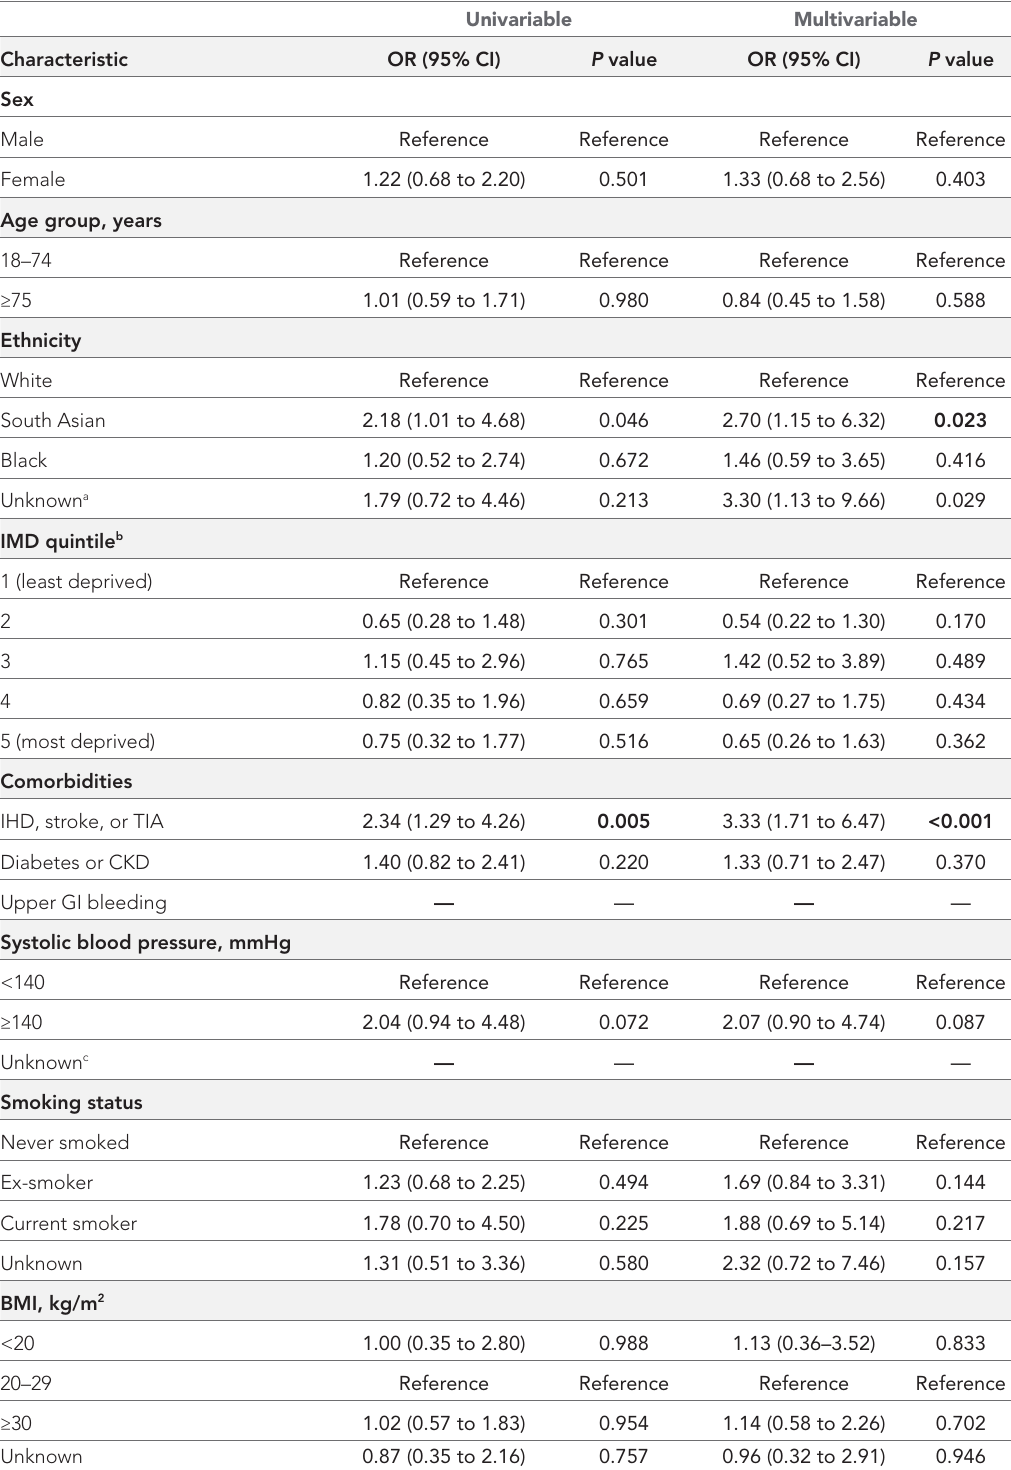
Table 4 Logistic regression models estimating the association of patient- related factors associated with PPI/H2RA prescription in individuals with AF on DAT Univariable Multivariable Characteristic OR (95% CI) P value OR (95%